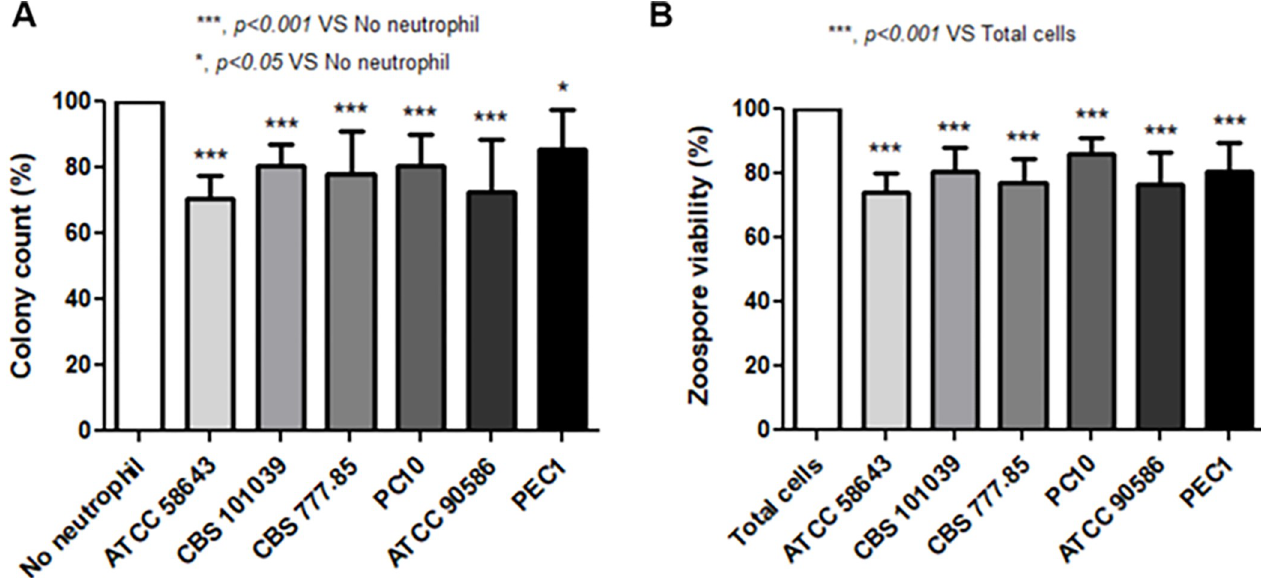
Fig 1. The killing activity of neutrophils against different strains of P . insidiosum zoospores. (A) Neutrophils from healthy donors (n = 6) were incubated with opsonized zoospores for 2 h. The percentage of colony counts on blood agar from each strain was calculated and compared with the same strain without neutrophils (100%). (B) The viability of zoospores after co-culture with or without neutrophils was observed using trypan blue staining under a light microscope, 400x magnification. The percentage of zoospore viability was calculated and compared with the same strain without neutrophils (100%). ( ��� p < 0.001, � p <